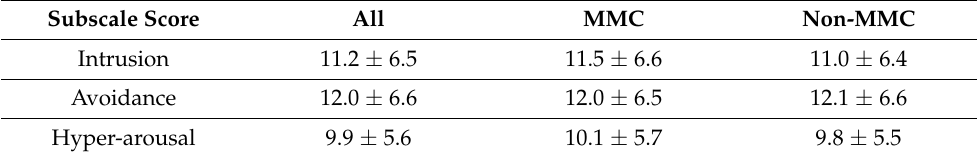
Table 3. IES-R subscale results in all, MMC, and non-MMC. Mean (SD).